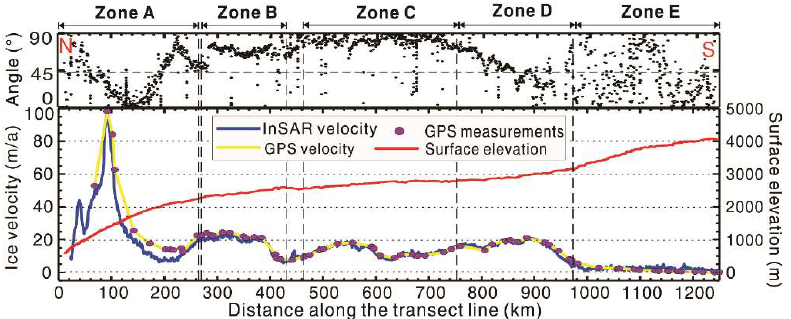
Figure 6. Surface elevation (red line), surface ice velocity distribution along the Chinese National Antarctic Research Expedition (CHINARE) traverse, and the angles between ice-flow and the traverse (black dot). The surface ice velocity vectors are derived from interferometric synthetic aperture radar (InSAR) data (blue line) [51,52] and Global Positioning System (GPS) data (yellow line) [39]. The purple points stand for the position of GPS measurement points. The red star marks the location of Taishan Station.